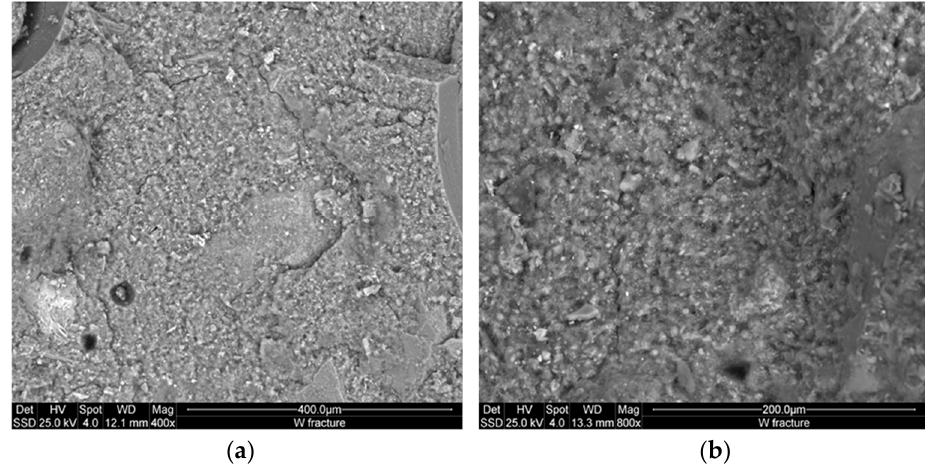
Figure 11. ESEM microstructure of fracture surface at high enlargements of the specimens with white ABS: ( a ) 400×; ( b ) 800× showing the relative poor impact of the low concentration of the iron metal during the process.